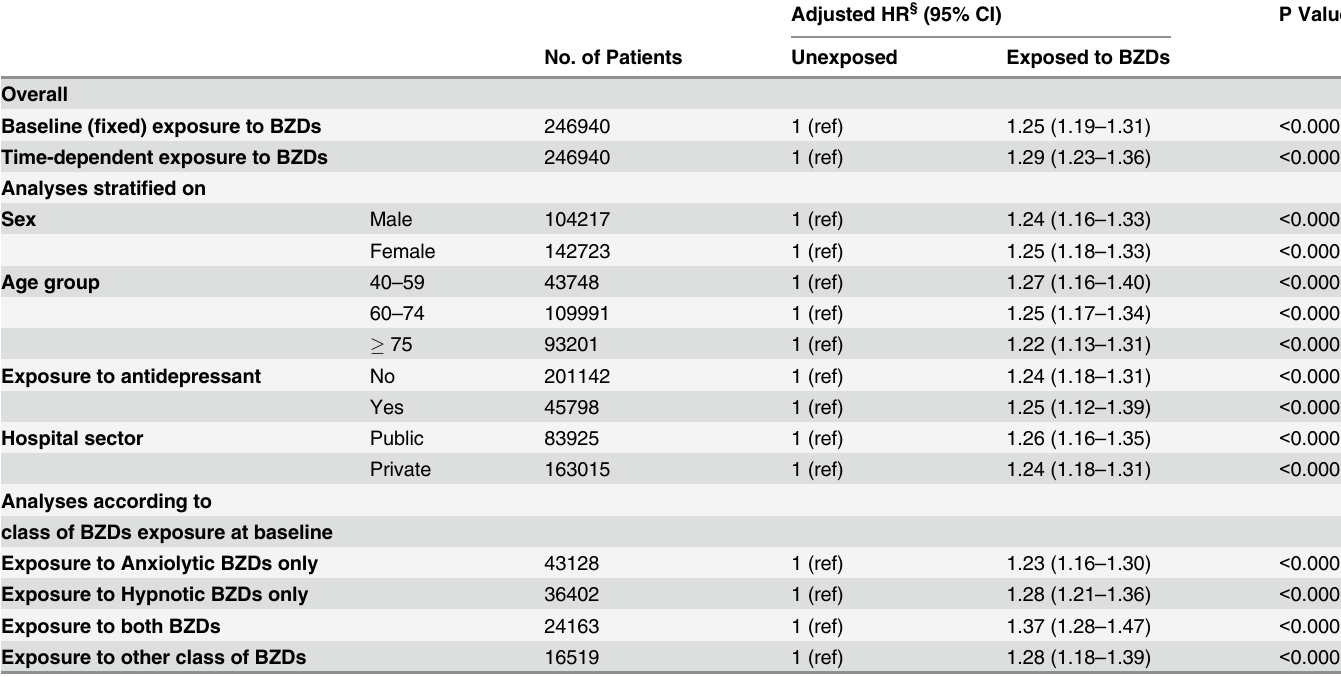
Table 4. Sensitivity analyses – Stratified analyses (with exposure to BZDs studied as binary